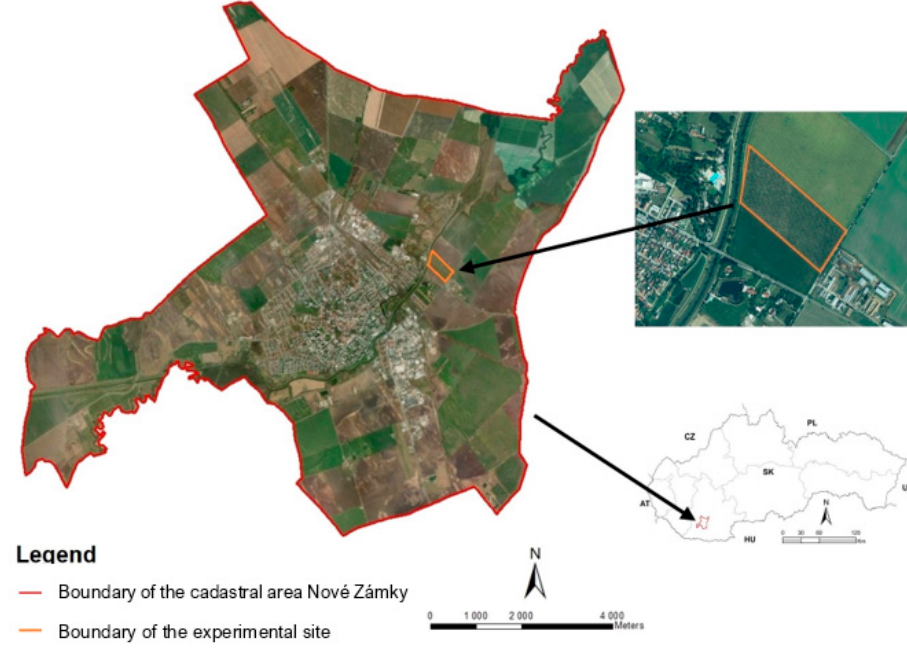
Figure 1. Location of the experimental site. Table 1. Precipitation totals and mean monthly air temperature in Nové Zámky in the growing season 2019 in comparison with climatic normal (1960–1991) [24].